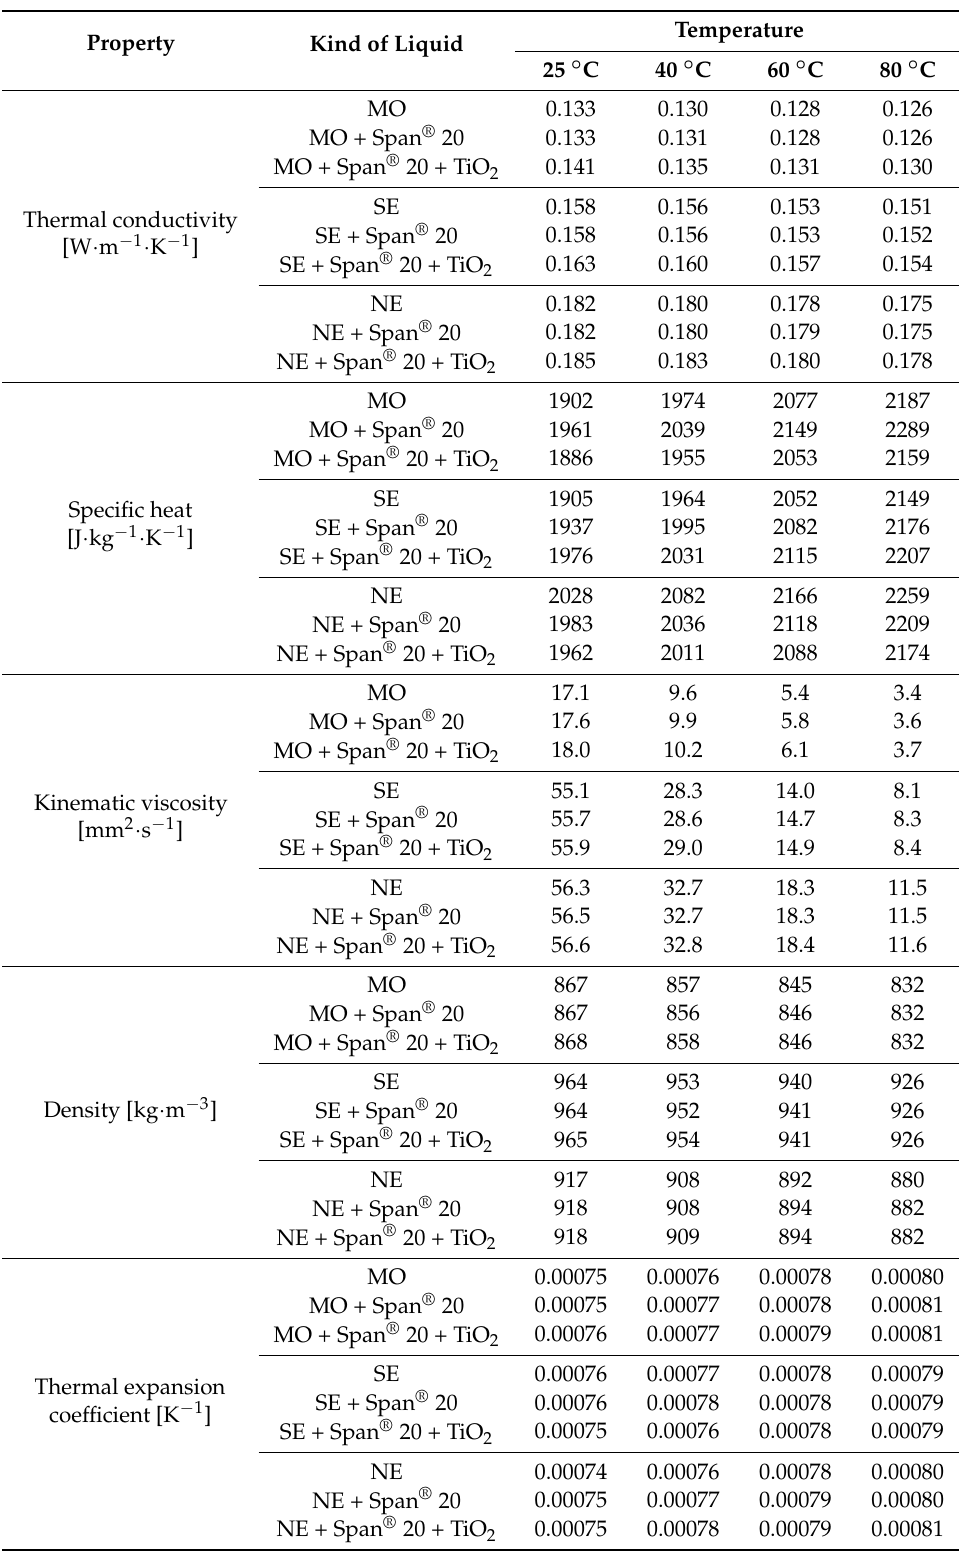
Table 6. Thermal properties of pure electro-insulating liquids and nanofluids based on surfactant Span ® 20 and titanium dioxide (TiO 2 )